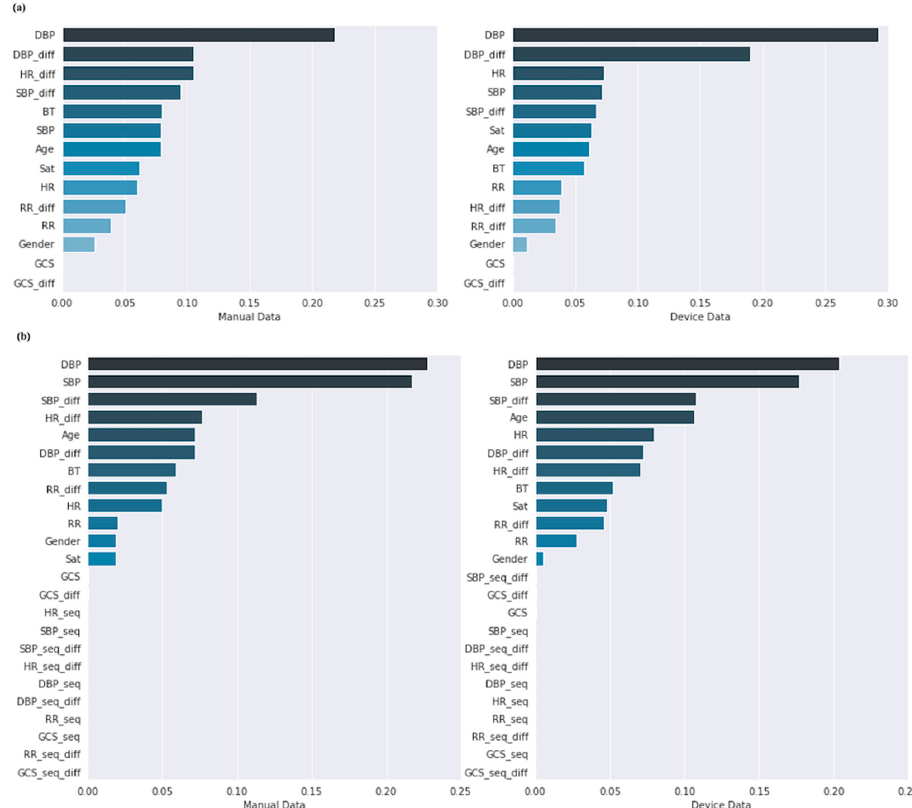
Figure 5. Feature importance scores of the models. ( a ) Fragmented model with manual data (left), with device data (right). ( b ) Accumulated model with manual data (left), with device data (right). SBP, systolic blood pressure; DBP, diastolic blood pressure, HR, heart rate; RR, respiratory rate; GCS, Glasgow coma scale; BT, body temperature; Sat, oxygen saturation; diff, difference; seq, sequence.